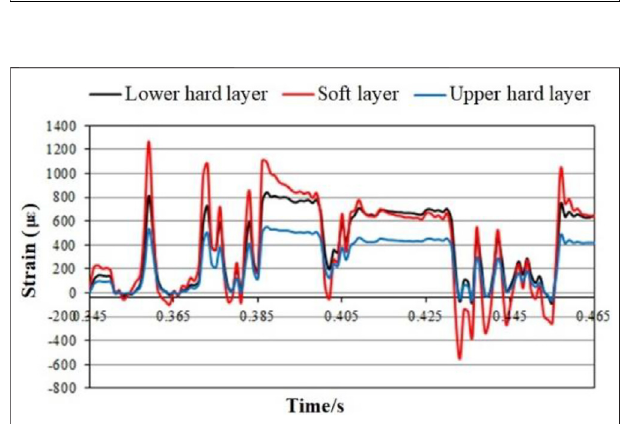
FIGURE 6 | Radial strain characteristic curve Ⅰ of each layer during simultaneous blasting of Nos 1, 2, and